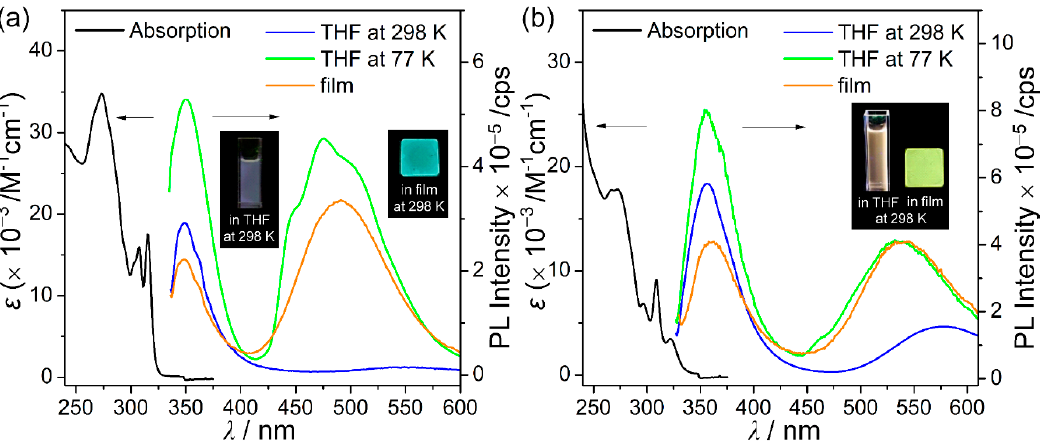
Figure 3. UV-vis absorption and photoluminescence (PL) spectra ( λ ex = 310 nm for C1 and 322 nm for C2 ) of ( a ) C1 and ( b ) C2 . Black: absorption spectra in tetrahydrofuran (THF) (30 μ M), blue: PL spectra in THF (30 μ M) at 298 K, green: PL spectra in THF (30 μ M) at 77 K, and orange: PL spectra in films (5 wt% doped with poly(methyl methacrylate) (PMMA)) at 298 K. The insets show the emission color of each state when irradiated with a hand-held UV lamp ( λ ex = 365 nm). Table 1. Photophysical data for spirobifluorene-based o -carboranyl compounds C1 and C2 . Compound